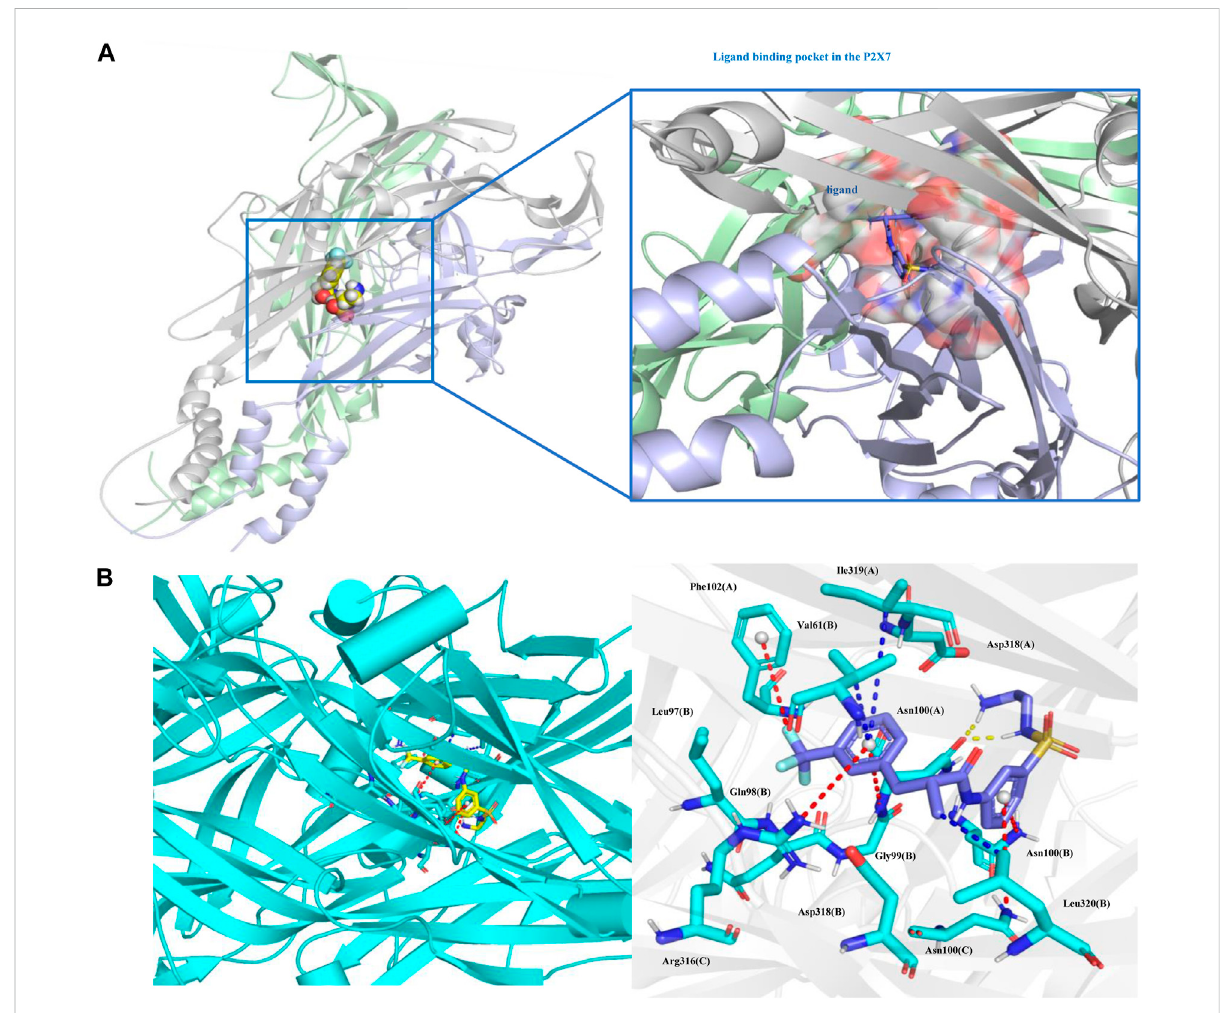
FIGURE. 10 Protein ‒ ligand binding pattern. (A) Protein ‒ ligand binding site. (B) Interacting amino acid residues and interaction force; the red dotted line represents the electrostatic force, the yellow dotted line represents the hydrogen bond, and the blue dotted line represents the hydrophobic force. Ligand (Z1456467176, blue) and P2X7R residues (green) are represented as stick